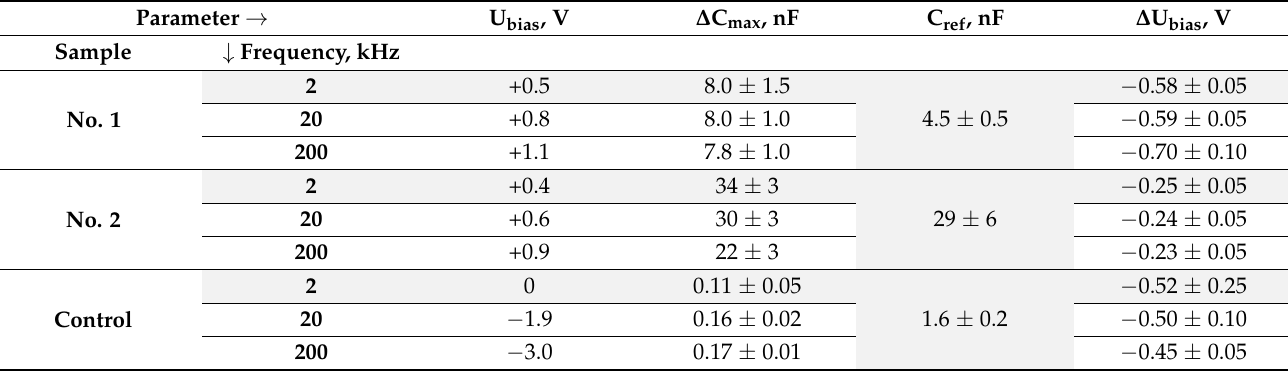
Designations: ∆ C max —maximum value of the sensor response under the act of Hydrogen, corresponding to the U bias value indicated in the Table; ∆ U bias —value of the sensor CV characteristic shift under the act of hydrogen, corresponding to the reference capacitance value C ref indicated in the Table. See Table 1 for other